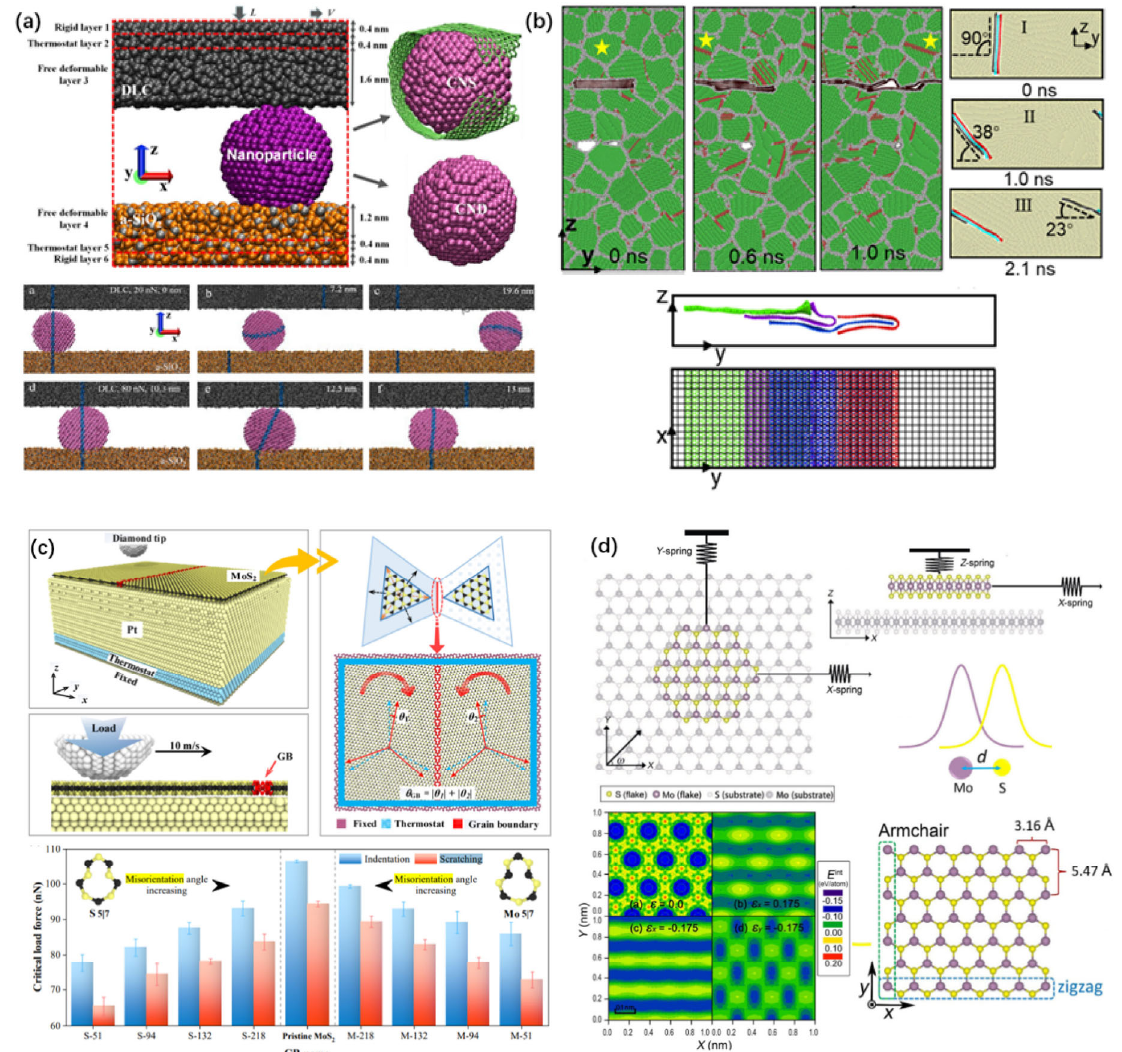
Fig. 82 Effects of grain boundary or in-plain strain on wear or superlubricity of 2D materials [967, 968, 971, 973]. Reproduced with permission from Ref. [967], © Elsevier Ltd., 2022; Reproduced with permission from Ref. [968], © Elsevier B.V., 2020; Reproduced with permission from Ref. [971], © The author(s), 2021; Reproduced with permission from Ref. [973], © The author(s),